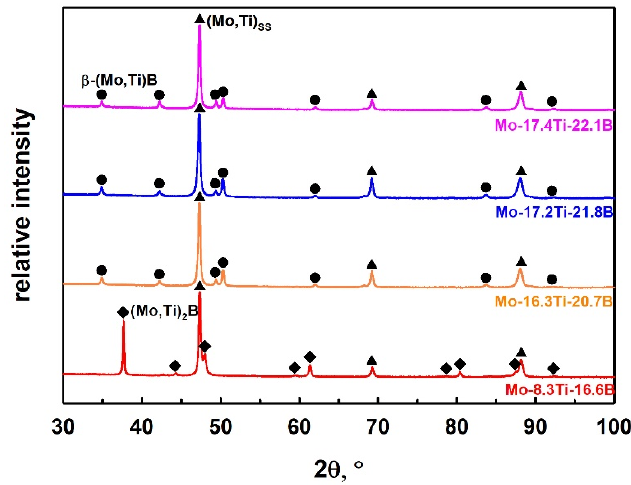
Figure 3. XRD patterns of as-cast Mo-Ti-B alloys.